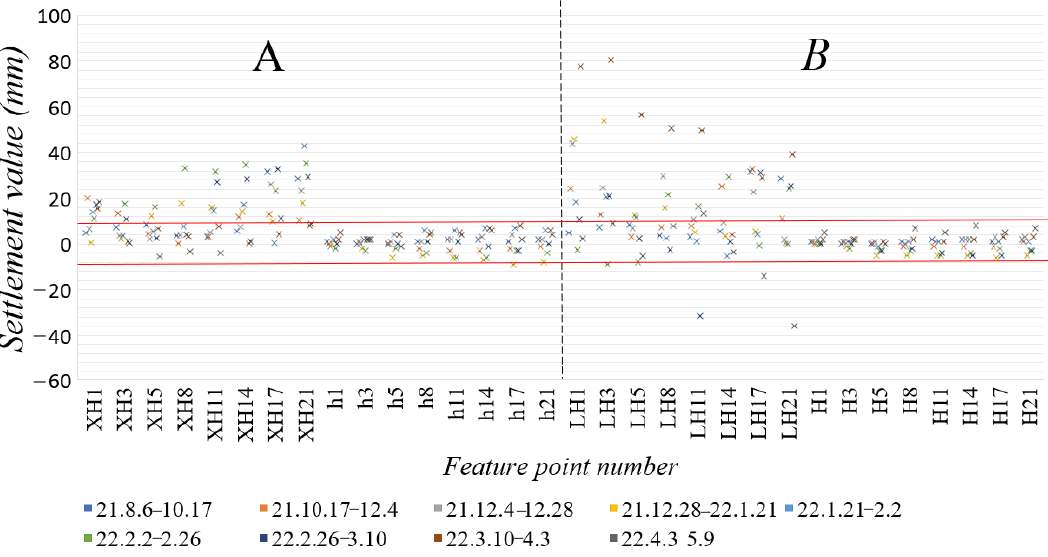
Figure 11. Comparison of the continuous subsidence ( A ) and cumulative subsidence ( B ) measured by some leveling monitoring points and the corresponding subsidence of D-InSAR (H1-H21 are the leveling monitoring points, XL1-XL21 are the corresponding D-InSAR detections The position of the image element point of the continuous deformation result, LH1-LH21 is the corresponding image element point position of the cumulative deformation result detected by D-InSAR, the range between the two red lines is the reasonable settlement interval, and the outside the red line is the vigilant settlement value).